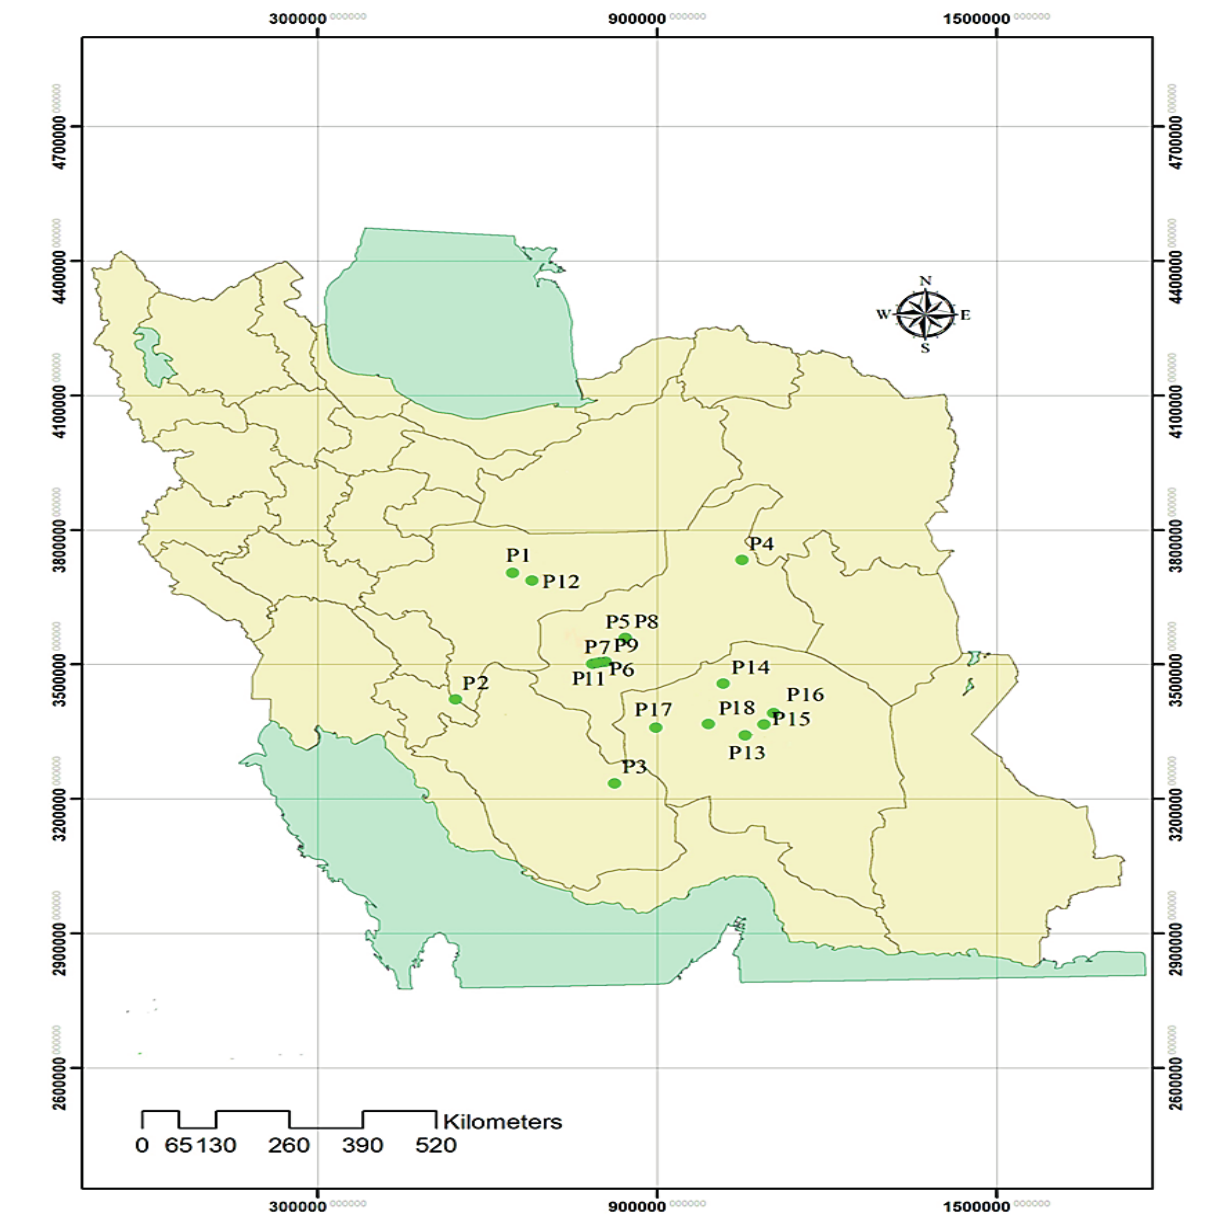
Figure 1. Geographic distribution of sampled Ferula assa-feotida L. on the map of Iran, using